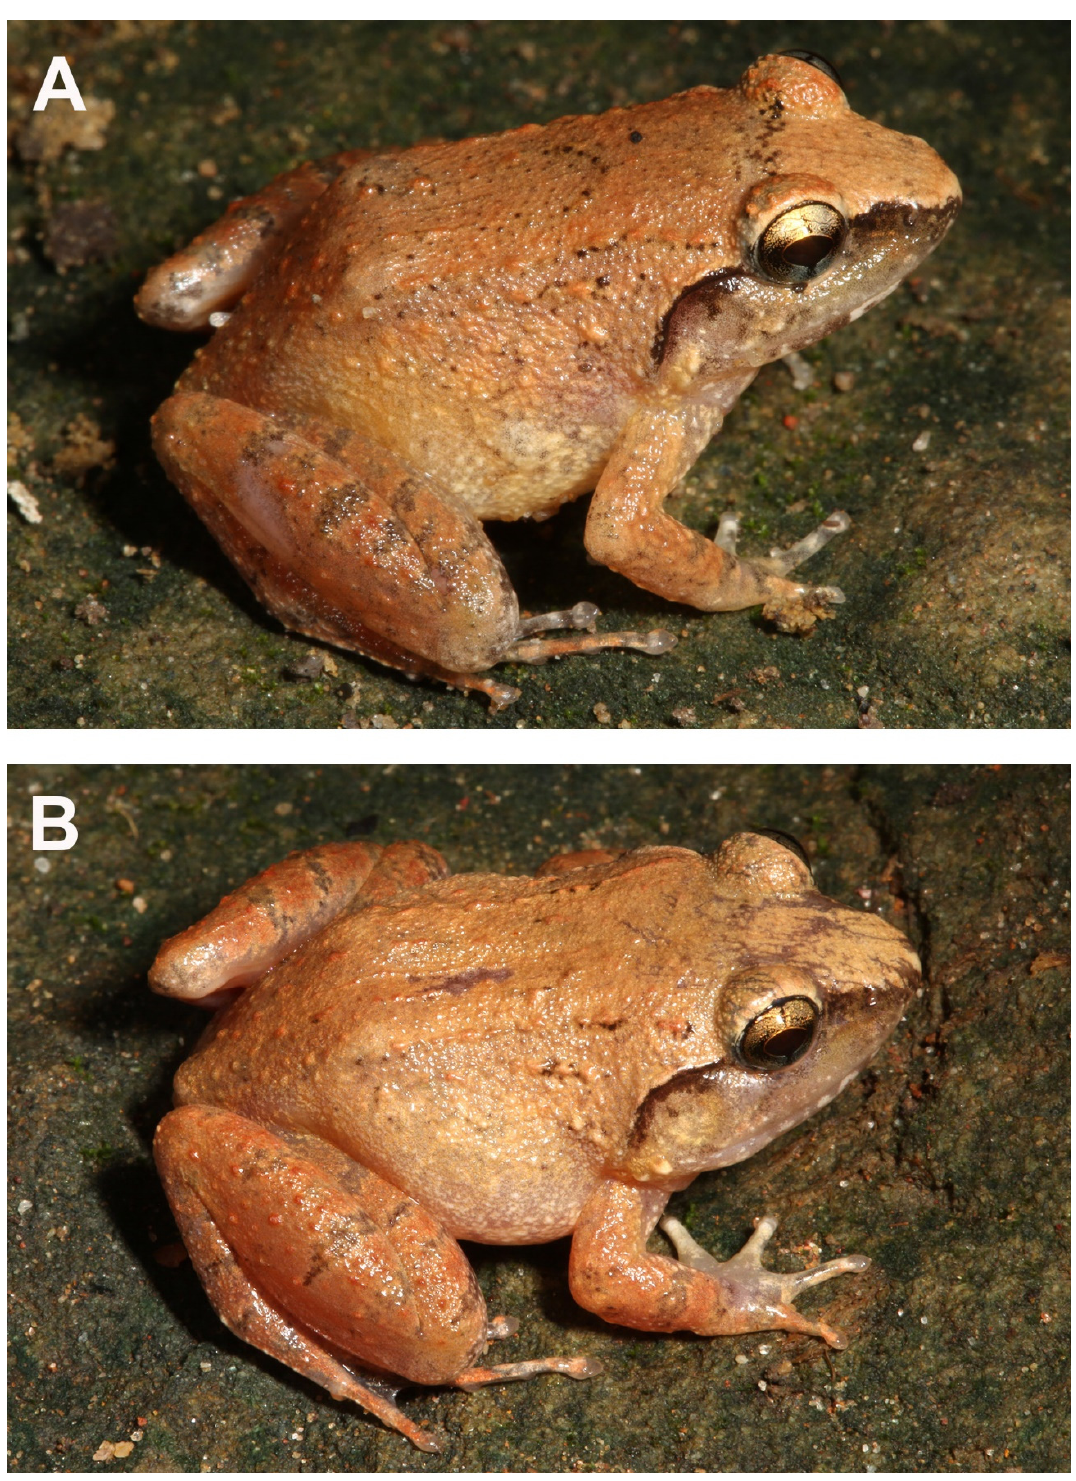
Figure 14. Limnonectes bagoyoma n. sp. in life. ( A ) Female holotype, SMF 106034; ( B ) Male paratype, SMF 106035. Photos by G.K.